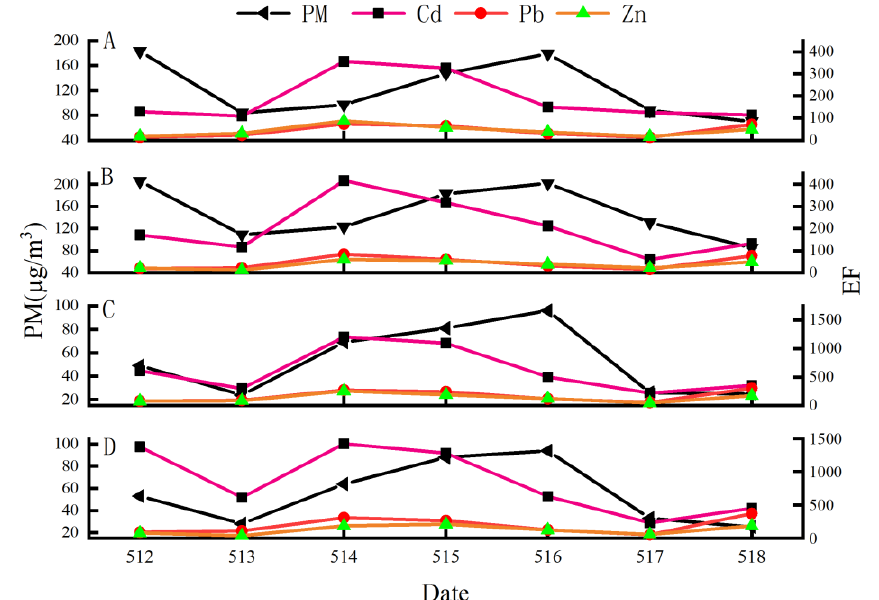
Figure 4. Relationship between Cd, Pb and Zn enrichment factors and particle concentration over time ( A : the PM 10 of sample site 1; B : the PM 10 of sample site 2; C : the PM 2.5 of sample site 1; D : the PM 2.5 of sample site 2).